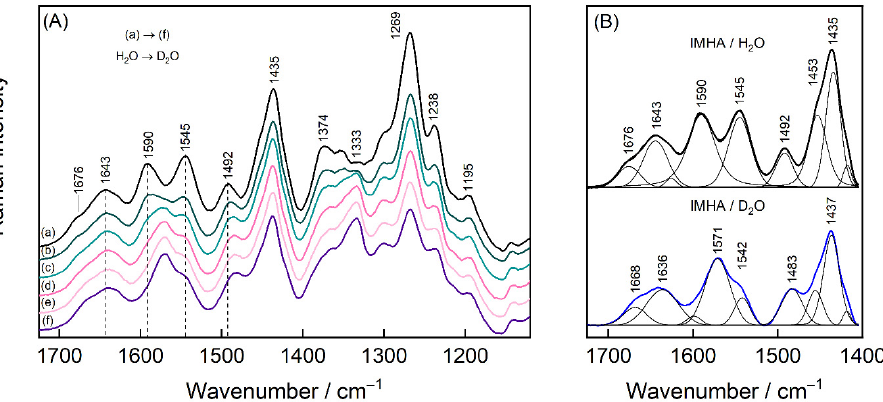
Figure 7. ( A ) SHINERS spectra in 1120–1725 cm − 1 region of IMHA monolayer at open circuit potential in PBS solution (a), which was gradually exchanged to D 2 O (b)–(f). In each step, 20 vol% of the solution was removed from the cell and then the same amount of D 2 O was added. ( B ) The spectra